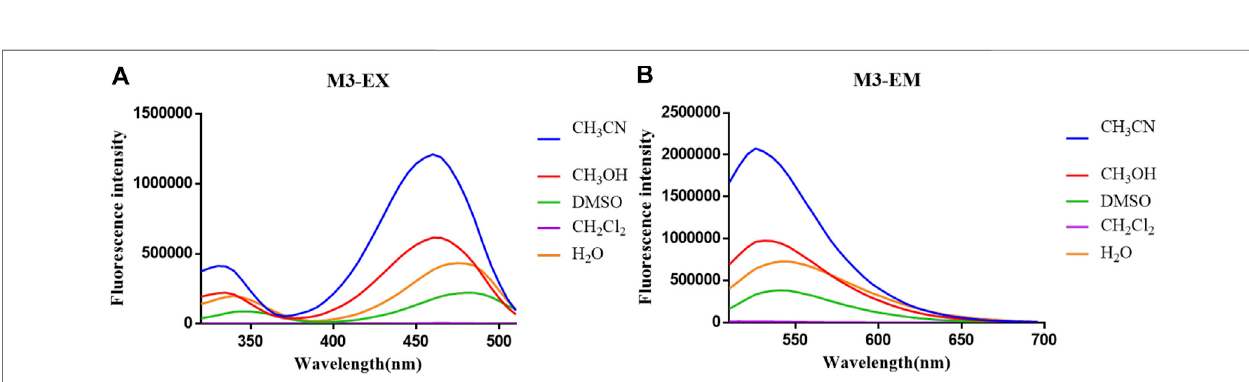
Frontiers in Molecular Biosciences |